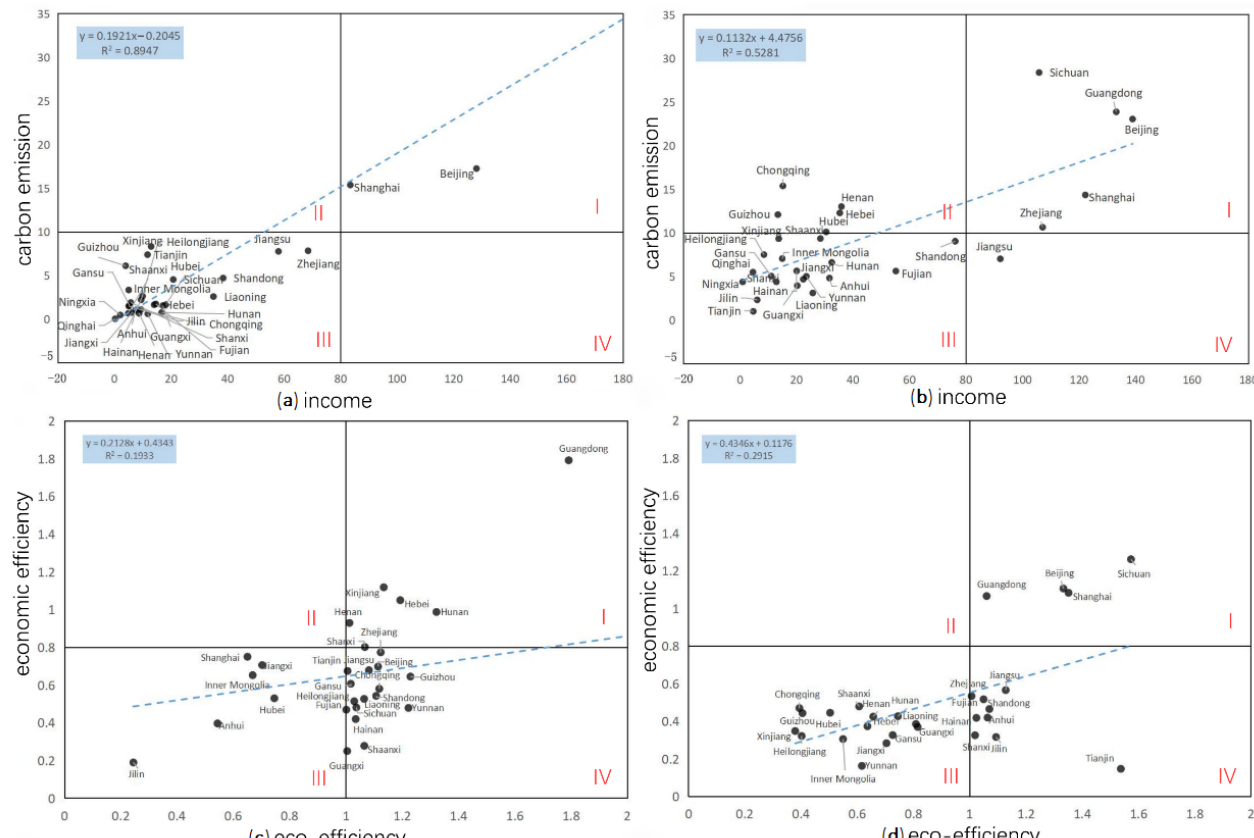
Figure 6. Coupled analysis of income–carbon emissions and economic efficiency–eco-efficiency of China’s tourist hotels in 2000 and 2019 (Qinghai is the heterogeneous point in ( c ) and Ningxia is the heterogeneous point in ( d )). ( a ) Coupled income and carbon emissions in 2000; ( b ) coupled income and carbon emissions in 2019; ( c ) coupling of economic efficiency and eco-efficiency in 2000; ( d ) Coupling of economic efficiency and eco-efficiency in 2019.